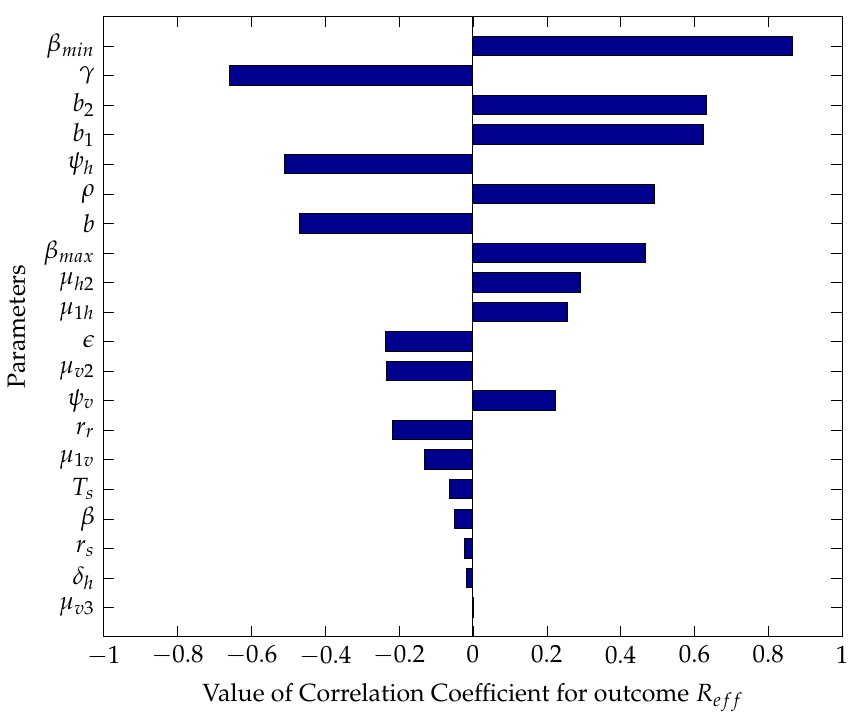
Figure 5. Tornado plot showing the sensitivities of the model parameters affecting the effective reproduction number.